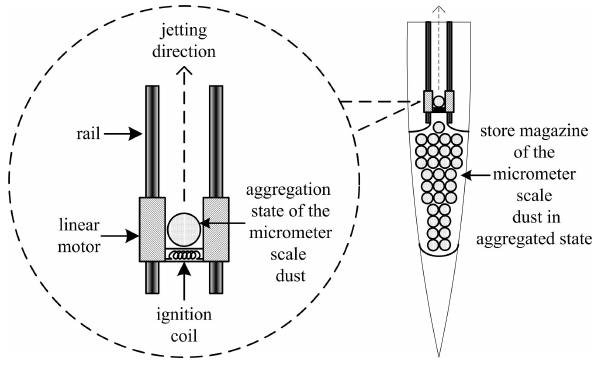
Figure 6. Jetting device